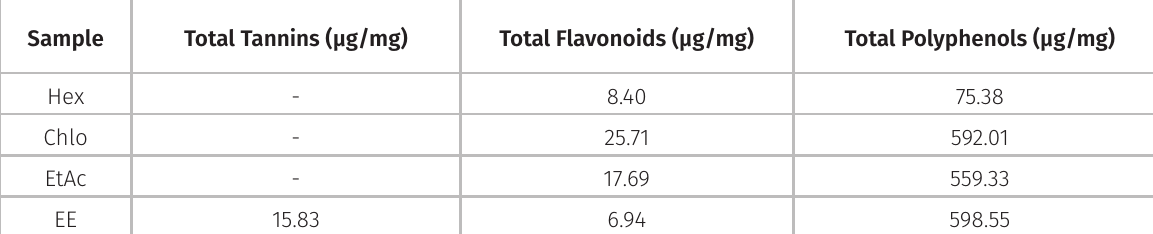
Table II. Content of total tannins, total flavonoids and total polyphenols of S. brasiliensis Engl. extract obtained by spectroscopy in the visible